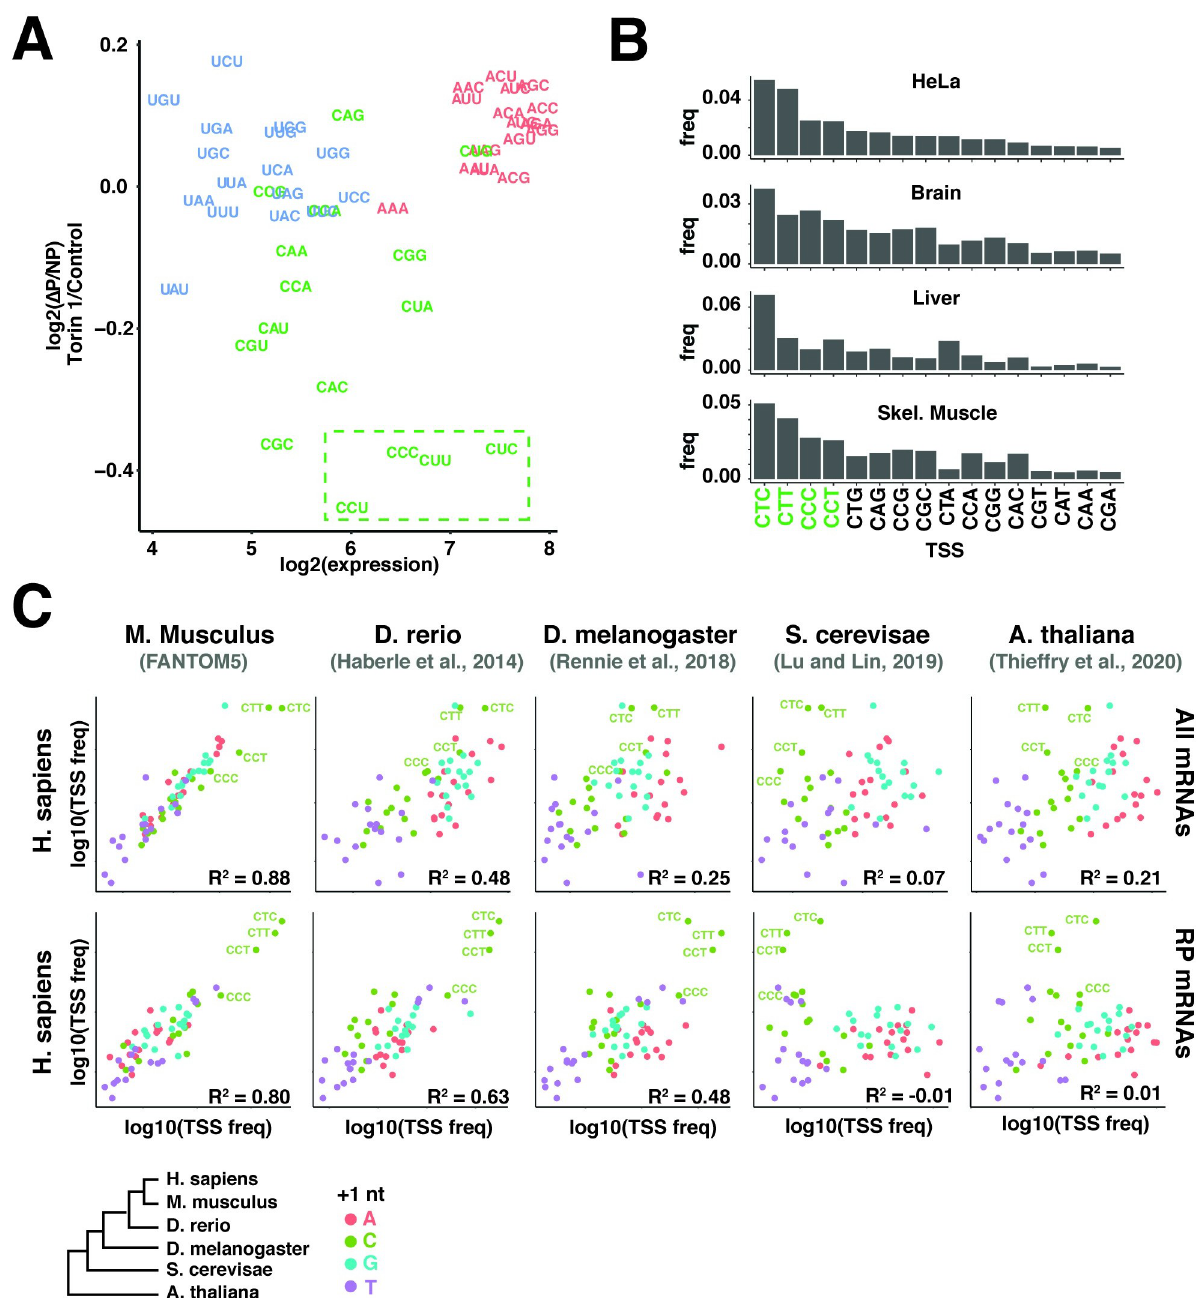
Fig 6. Endogenous TSSs are TCT/TOP hybrids optimized for both transcription and post-transcriptional regulation. (A) Comparison of translation and transcription functions of TSSs. The expression levels (Fig 2A) and mTOR-regulated translation (Fig 4B) of 5 0 3mer sequences are shown, colored by +1 nucleotide. The indicated TOP/TCT hybrids CTC, CCC, CTT, and CCT 5 0 sequences maximize transcription and translation regulatory functions. (B) TCT/TOP 5 0 sequences are enriched in endogenous mRNAs. Expression levels of the indicated +1 C 5 0 sequences in hCAGE data from HeLa cells and the indicated human tissues. (C) Conservation of TSS usage across 6 species. Upper panel: Frequencies of 5 0 3mer sequences in CAGE reads mapping to 1 kb regions surrounding the 5 0 ends of annotated transcripts in the indicated species were compared to 3mer frequencies in human (HeLa) hCAGE data. Lower panel: Frequencies of 5 0 3mer sequences in CAGE reads mapping to 1 kb regions surrounding the 5 0 ends of annotated transcripts encoding ribosomal proteins from the indicated species. TCT/TOP sequences CTC, CCC, CTT and CCT are indicated.